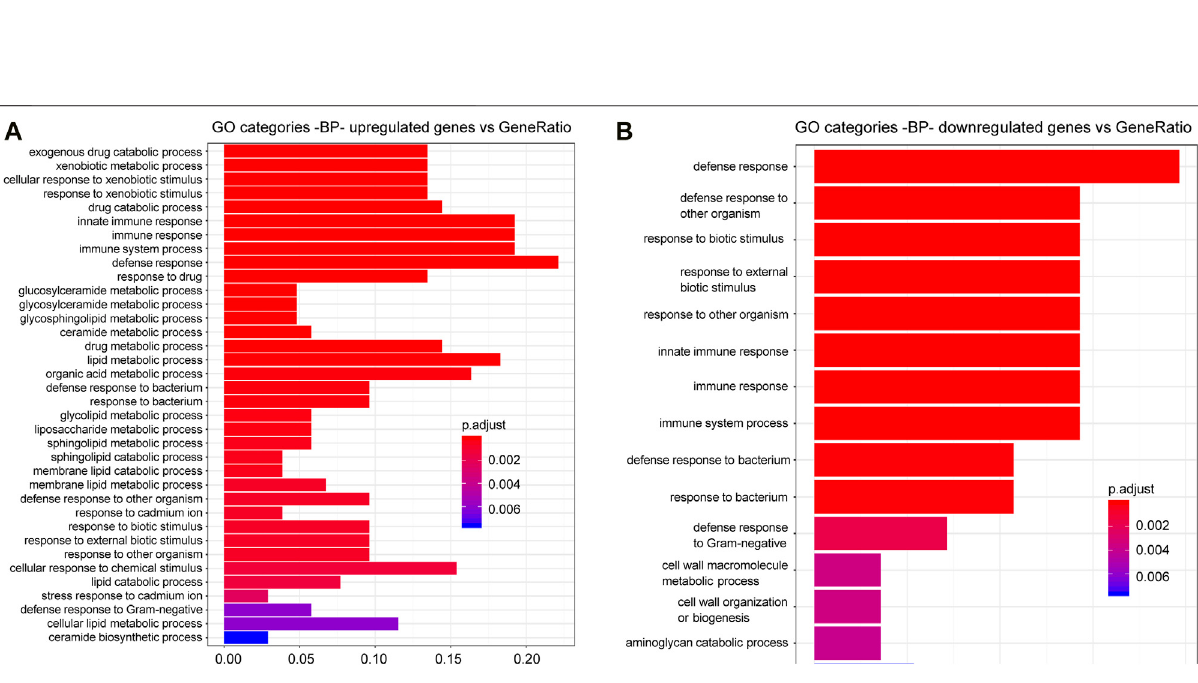
Frontiers in Pharmacology |